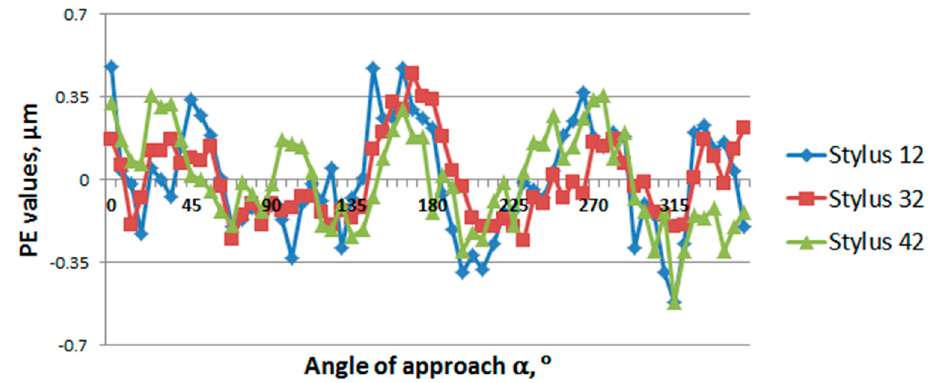
Figure 2. The probe error (PE) values depending on the angle of probe approach α , obtained for different styli lengths.